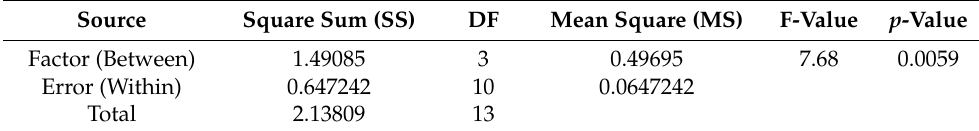
Table 9. Effect of P1 fiber type and temperature on f L by applying ANOVA analysis.